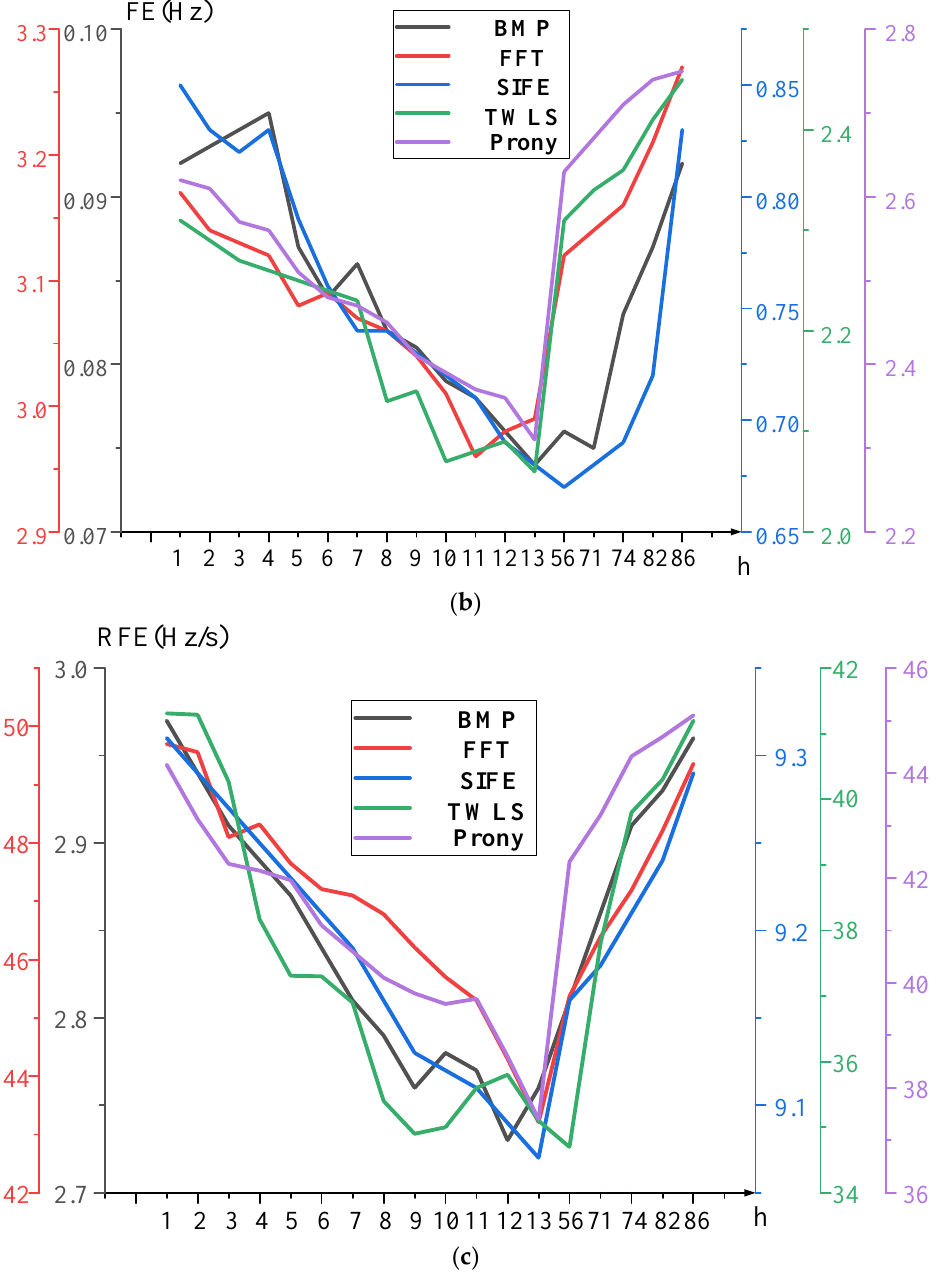
Figure 2. Maximum errors of TVE, FE, and RFE under frequency ramp conditions. ( a ) TVE. ( b ) FE. ( c ) RFE .